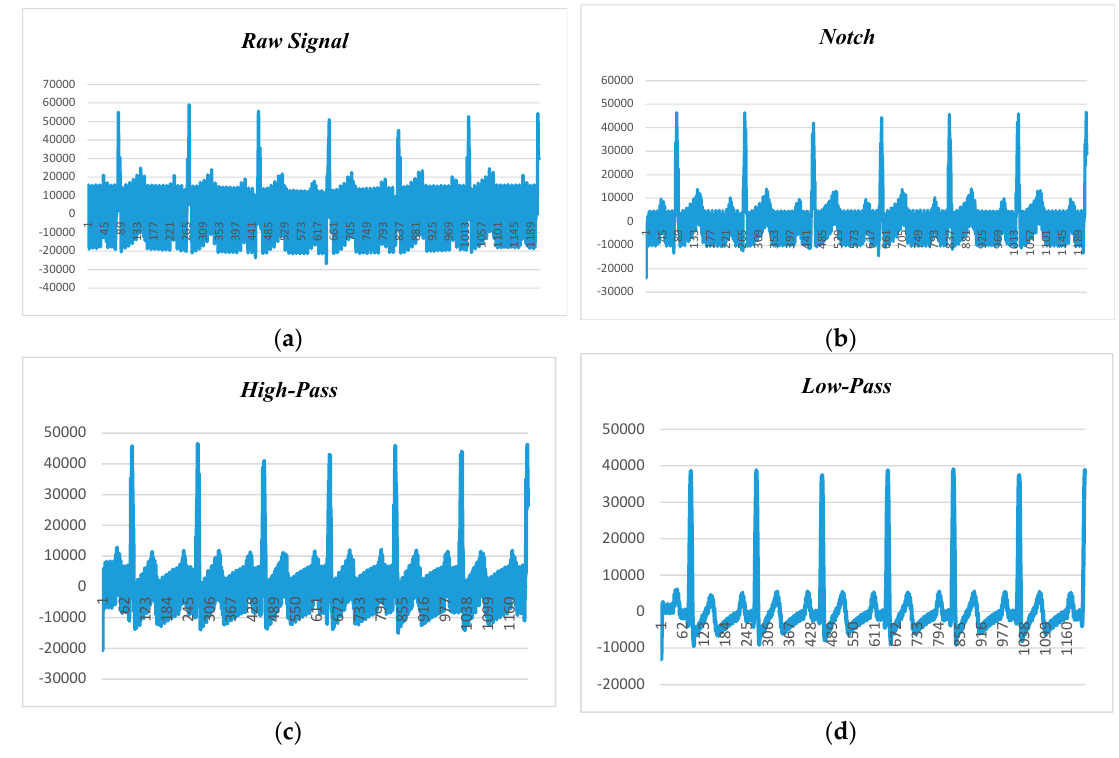
Figure 10. ECG data filtering at 80 BPM and 50 Hz noise: ( a ) raw data; ( b ) notch filter; ( c ) high-pass filter (HPF); ( d ) low-pass filter (LPF).